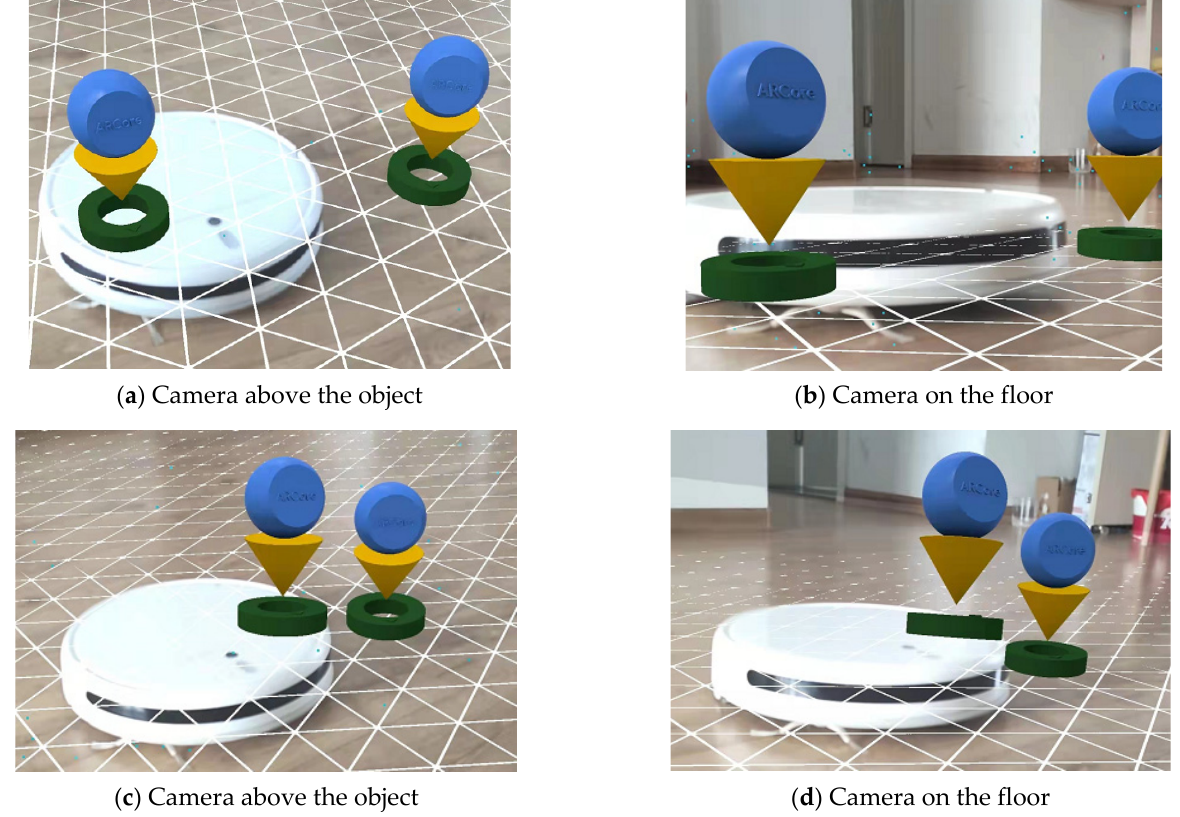
Figure 10. Image ( a , b ) are results of ARCore without the proposed method; image ( c , d ) are results of